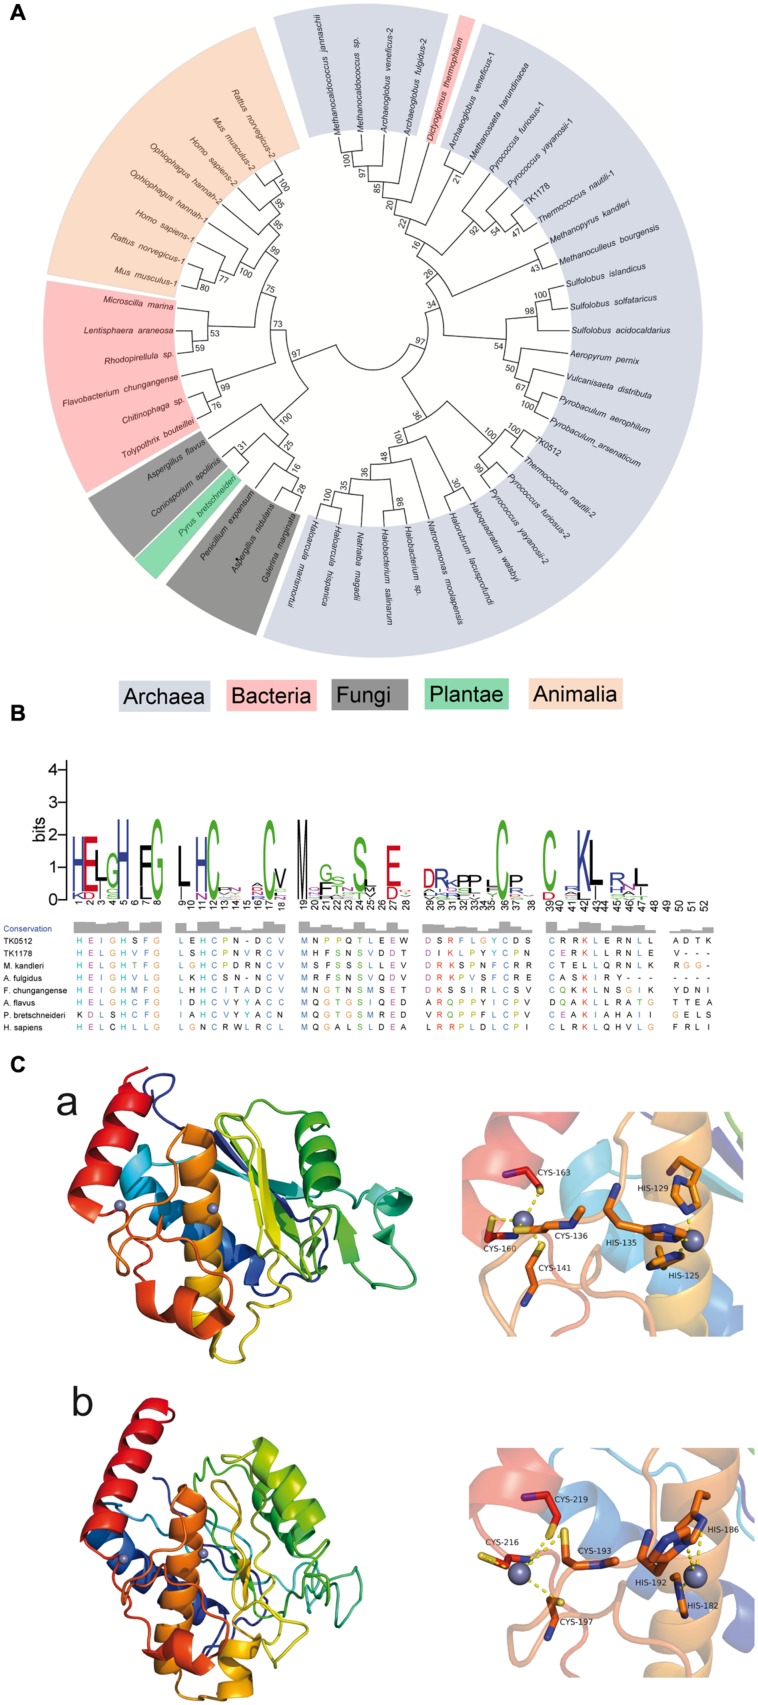
Phylogenetic, sequence, and structure analysis of AMZ-tk and other archaemetzincins. (A) Unrooted neighbor-joining phylogenetic tree for 50 archaemetzincins from archaea, bacteria, and eukarya (in different colors) generated using MEGA5. The optimal tree with a sum of branch length = 13.47550492 is shown. The percentage of replicate trees in which the associated taxa clustered together in the bootstrap test (1000 replicates) is shown next to the branches. (B) Sequence alignment of conserved zinc-binding motif of AMZ-tk and other homologs. The conserved zinc-binding motif of archaemetzincin from archaea (TK0512 (AMZ-tk), YP_182925.1; TK1178, YP_183591.1; Methanopyrus kandleri, WP_011018918.1; Archaeoglobus fulgidus, WP_010877837.1), bacteria (Flavobacterium chungangense, WP_031453746.1), fungi (Aspergillus flavus, XP_002379891.1), plantae (Pyrus bretschneideri, XP_009350639.1), and animalia (Homo sapiens, NP_001275985.1) was aligned by ClustalW. The conservation level of each residue is indicated by the height of the bars above each residue. The sequence logo was generated using WebLogo (http://weblogo.berkeley.edu/). (C) Homology modeling of AMZ-tk. The structure was generated by homology modeling using archaemetzincin from M. Kandleri (PDB code: 2X7M) as a template. (a) The overall structure (left) and Zinc-binding residues (right) in archaemetzincin from M. Kandleri. (b) The three-dimensional model structure (left) and Zinc-binding residues (right) in AMZ-tk.